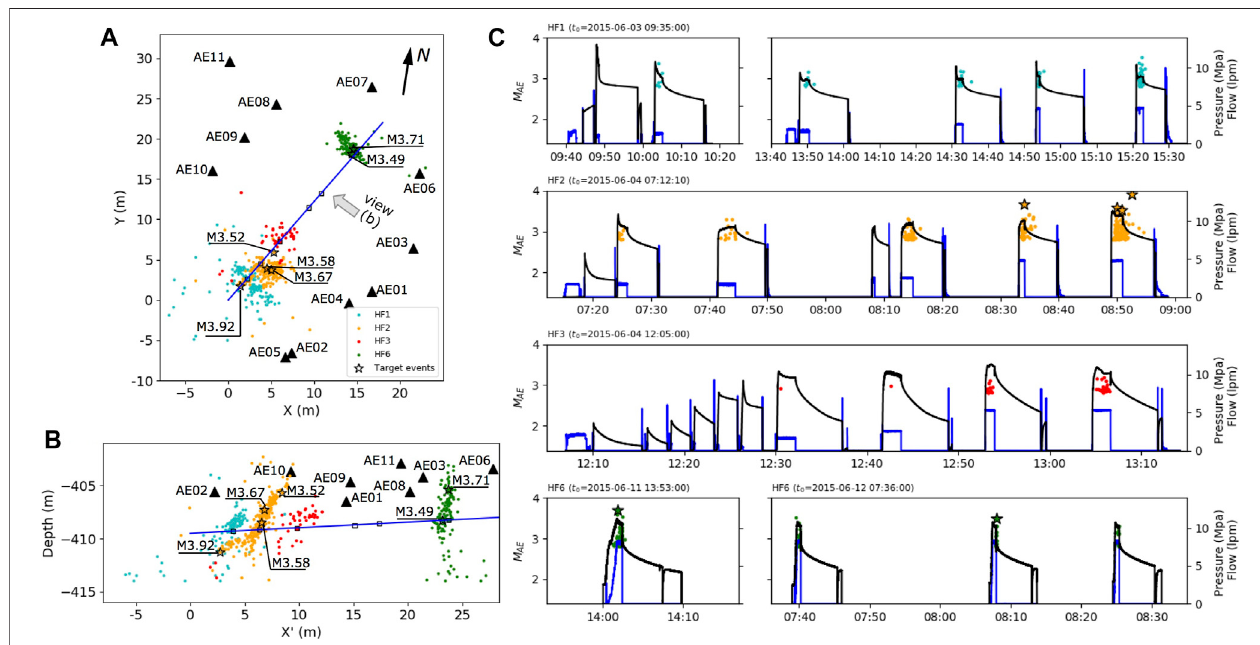
FIGURE 1 | (A) and (B) AE hypocenters with M AE > 2.8 located in the hydraulic fracturing experiments in the Äspö HRL from the last updated catalogue of Niemz etal.(2020).StarsdenotethelargestAEeventsanalyzedinthisstudy,indicatingthecorrespondingM AE .TheAEsensors(triangles)andinjectionintervals(squares)along the 28-m-long injection borehole (blue line)are also shown.The direction ofviewin (B) isindicated in (A) . (C) Temporal evolution oftheAEevents ofeach HF experiment shown in (A) is plotted together with the injection pressures (black lines) and fl ow rates (blue lines). Initial time (t 0 ) is indicated for each plot. HF1, HF2 and HF6 were performed with a conventional continuous injection scheme, while a cyclic progressive injection scheme is followed in HF3 showing less AE activity and lower M AE